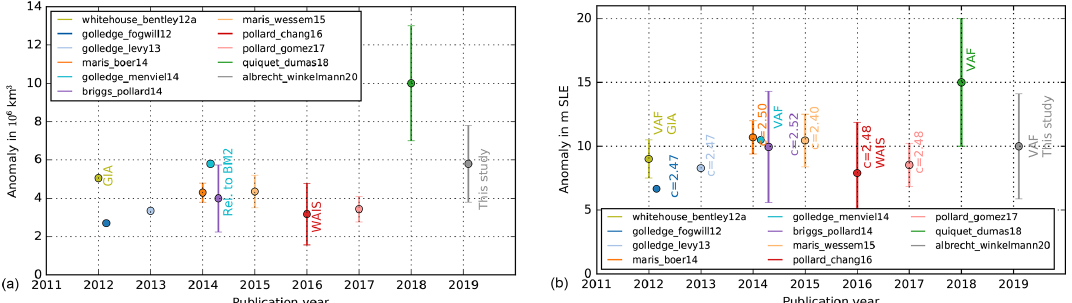
Figure 11. Ice volume anomaly between Last Glacial Maximum as compared to present (not observations) in recent modeling studies in units of 10 6 km 3 (a) and in units of meters sea-level equivalent (b) . Note that the study by Pollard et al. (2016) only considers the West Antarctic subdomain in their analysis (reddish). Golledge et al. (2012, 2013, 2014) and this study used PISM (blue and grey), Maris et al. (2014, 2015) used ANICE (orange), Whitehouse et al. (2012a) used Glimmer simulations (olive), Quiquet et al. (2018) used GRISLI simulations (green), and Pollard et al. (2016, 2017) used PennState3D (or PSU-ISM) as model (blueish) coupled to different Earth models. Be aware that ice volume estimates are based on different ice densities in the different models and that different conversion factors c were used. This study, Golledge et al. (2014), as well as the Glimmer and GRISLI model, provided the volume above flotation (VAF), which subtracts some portion of the ice volume in panel (b) . The provided uncertainty ranges are not necessarily symmetric; e.g. the upper range in Briggs et al. (2014) has less confidence than the lower range.